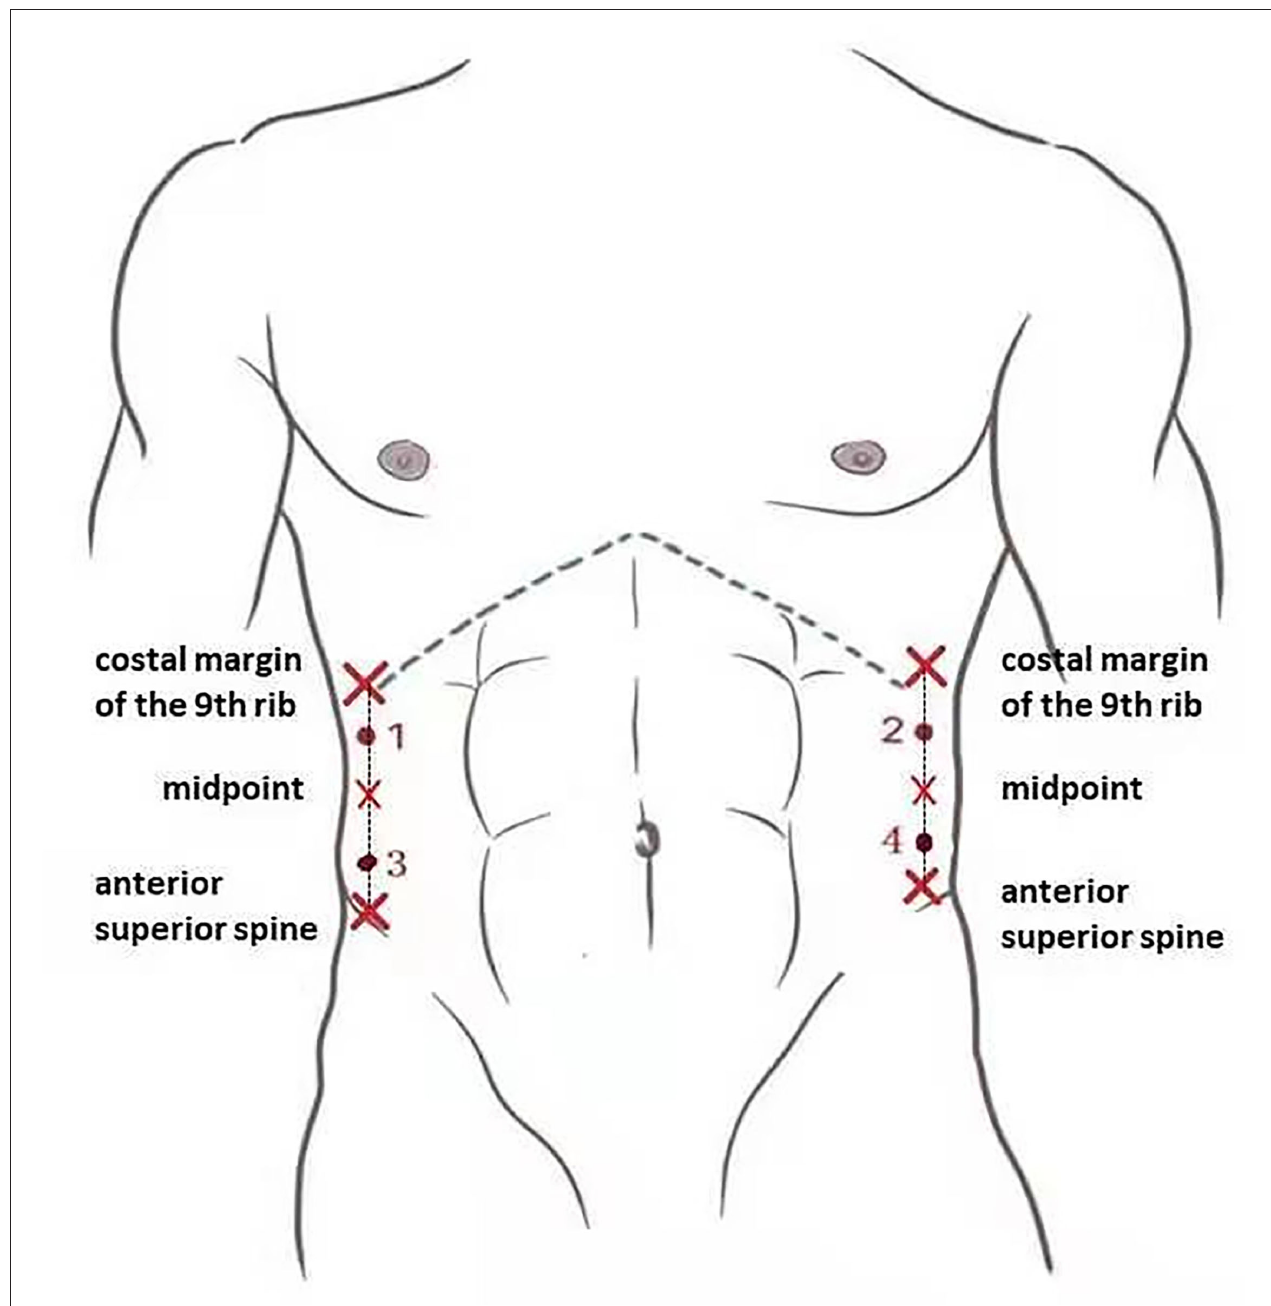
FIGURE 3 | The four measurement points used for shear wave elastography on the anterolateral abdominal wall